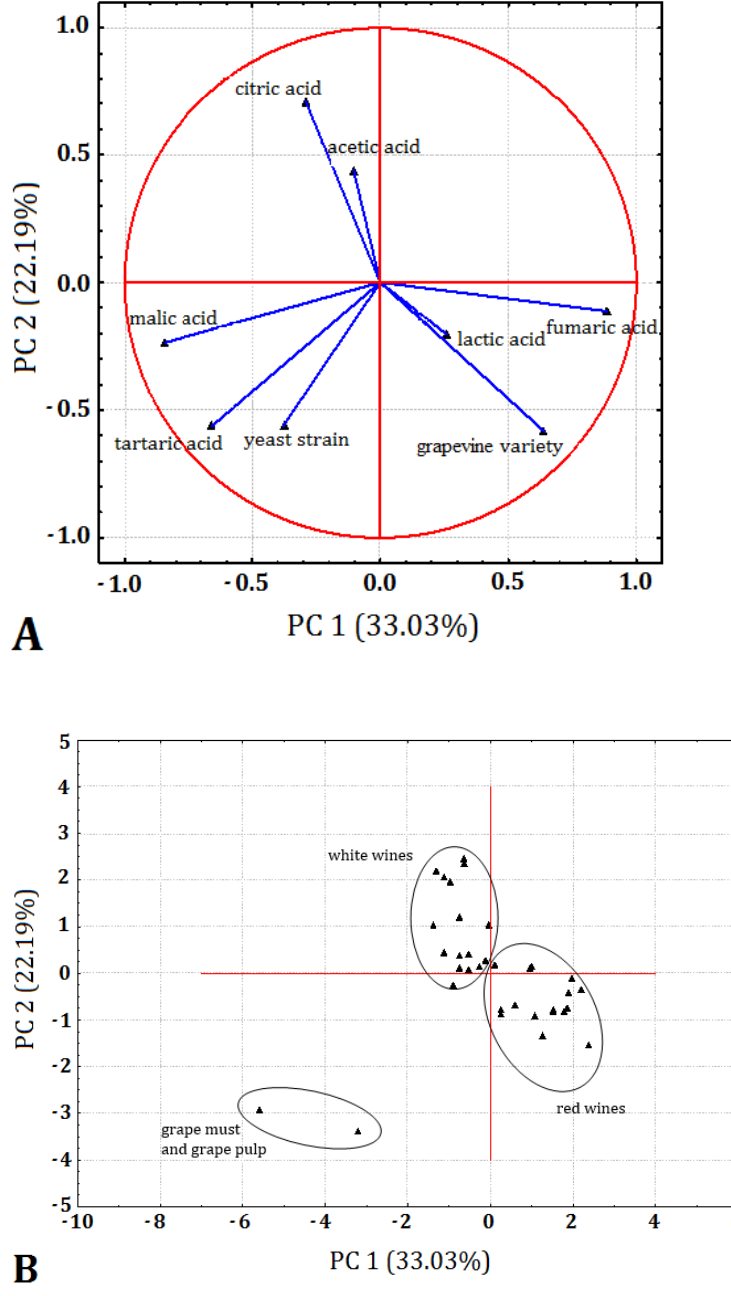
Figure 7. Principal Component Analysis plot for organic acids formed during alcoholic fermentation. ( A ) Loading plot, ( B) Score plot.